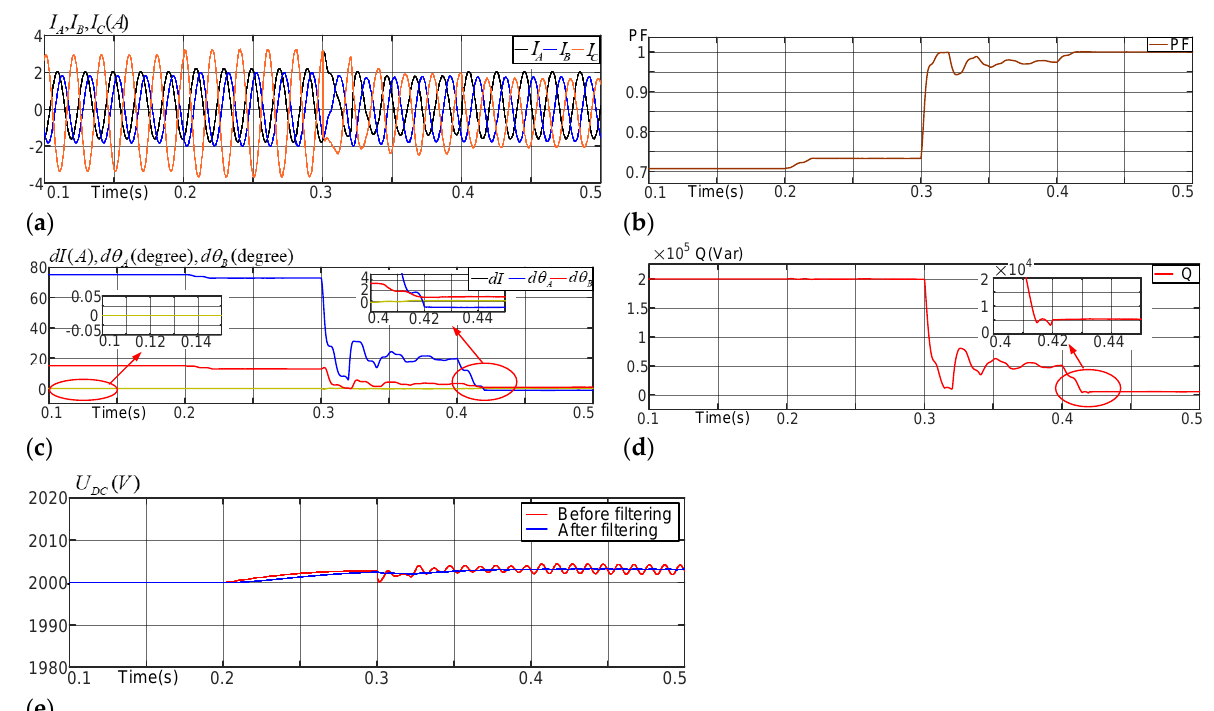
Figure 10. Simulation results of Case 1. ( a ) Primary side currents of V/v transformers I A , I B and I C ; ( b ) Primary side power factor (PF) of the V/v transformer; ( c ) dI , dθ A and dθ B ; ( d ) Total reactive power of the power supply system Q ; ( e ) DC capacitor voltage before and after filtering.